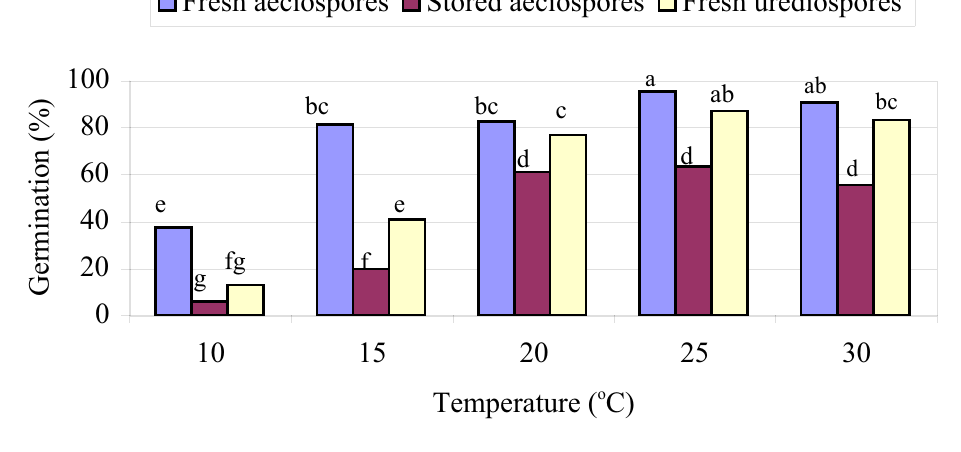
Fig. 1. Effect of temperature on percent germination of fresh and stored aeciospores and of fresh urediospores of Pileolaria terebinthi. Bars with the same letter(s) are not significantly different ( P